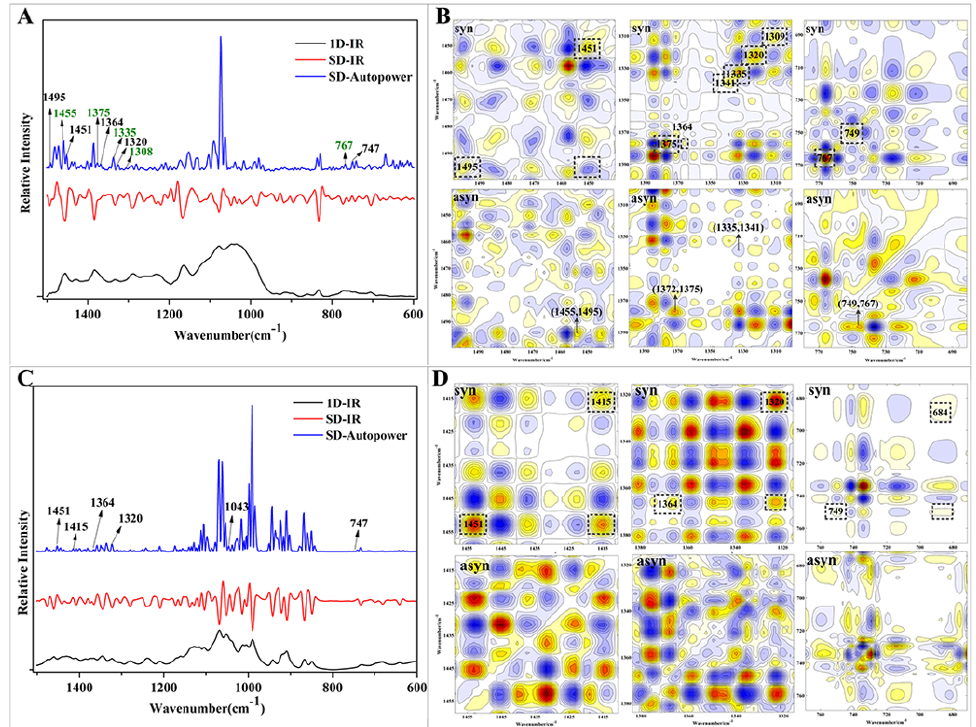
Figure 1: 1D, SD, power spectrum (A), synchronous and asynchronous spectra (B) of Sample 6; 1D, SD, power spectrum (C), synchronous and asynchronous spectra (D) of Sample 7. Reprinted from Miao et al. (2016) with permission from John Wiley and